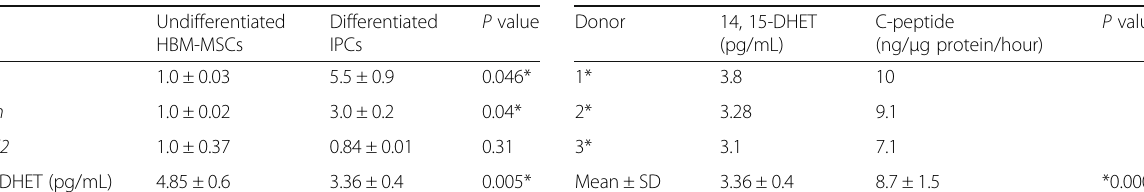
Table 4 14, 15 - DHET concentrations and C-peptide released from differentiated IPCs incubated in KRB containing 25 mM/L